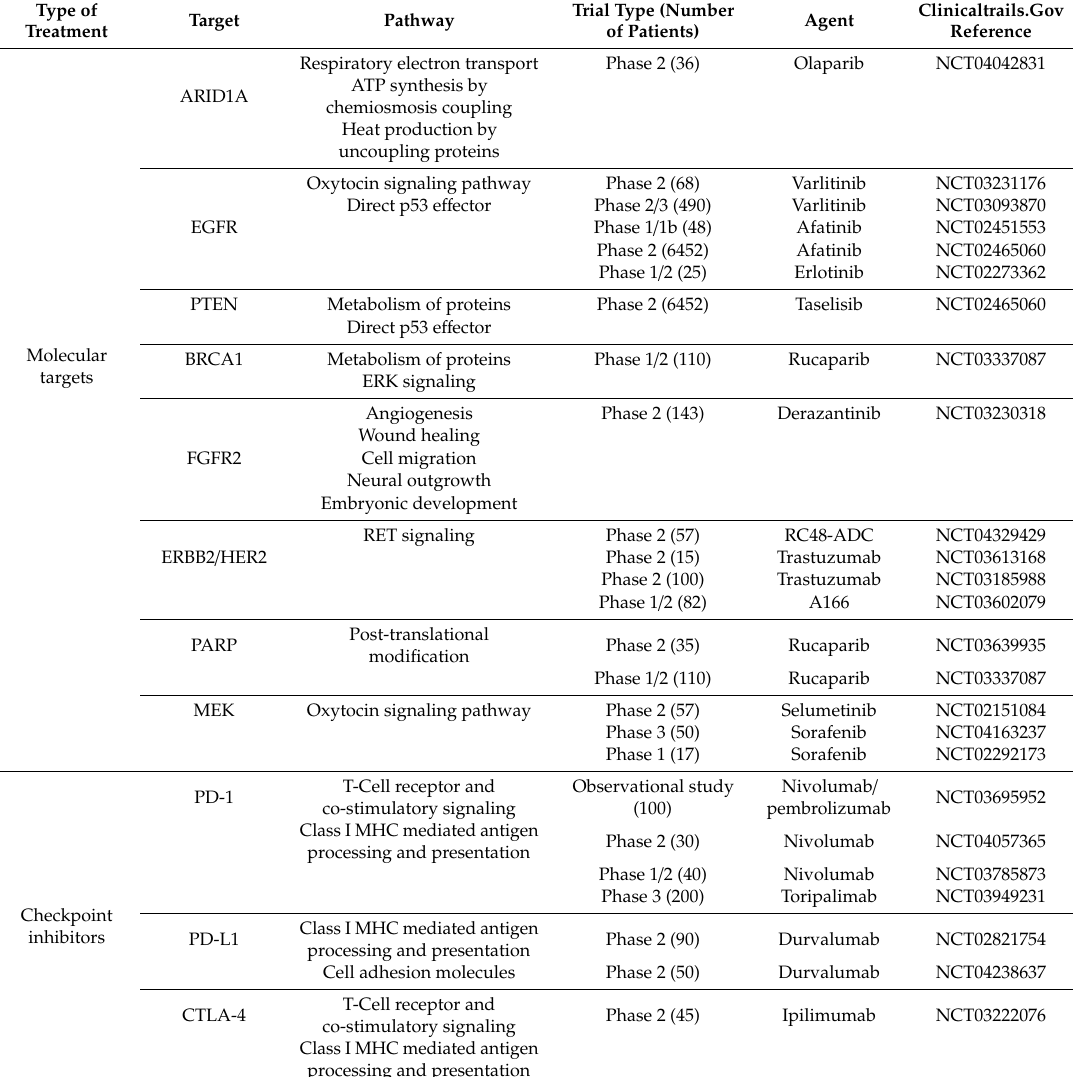
Table 1. Selected Ongoing Clinical Trials in BTCs Targeting Molecular Mutations / Fusions And Using Immune Checkpoint Inhibitors Alone or in the